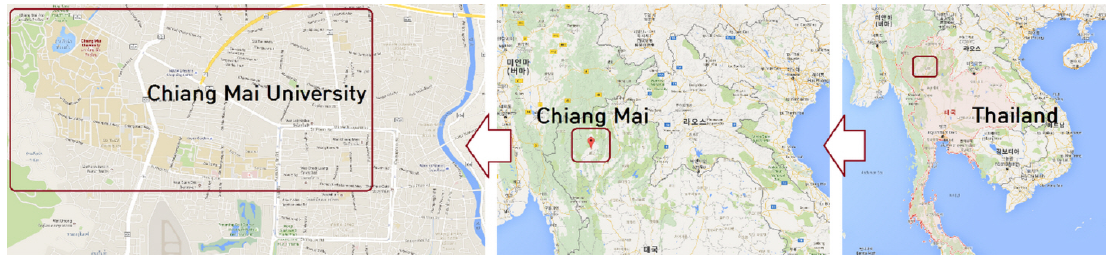
Figure 1. The location of Chiang Mai University (created by the